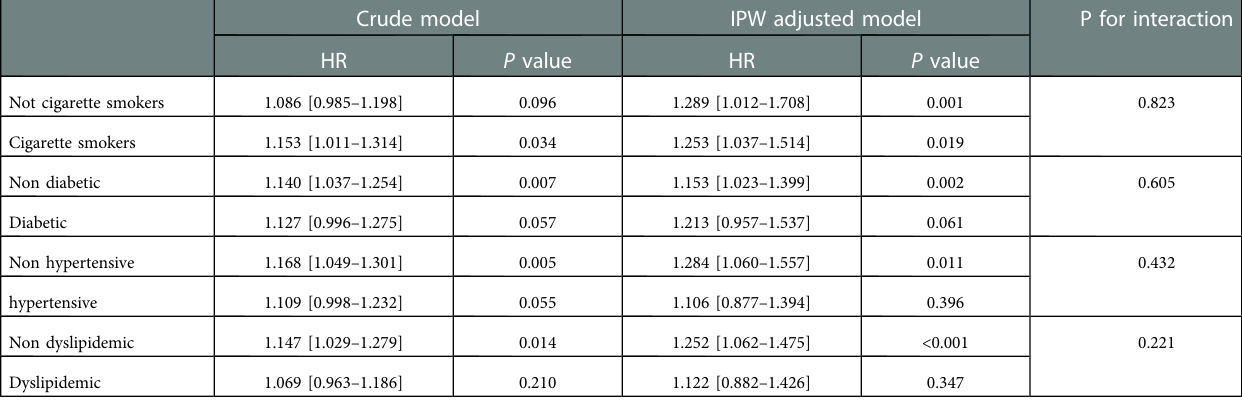
TABLE 4 MACCE hazard ratios for opium consumption based on each CAD risk factor.